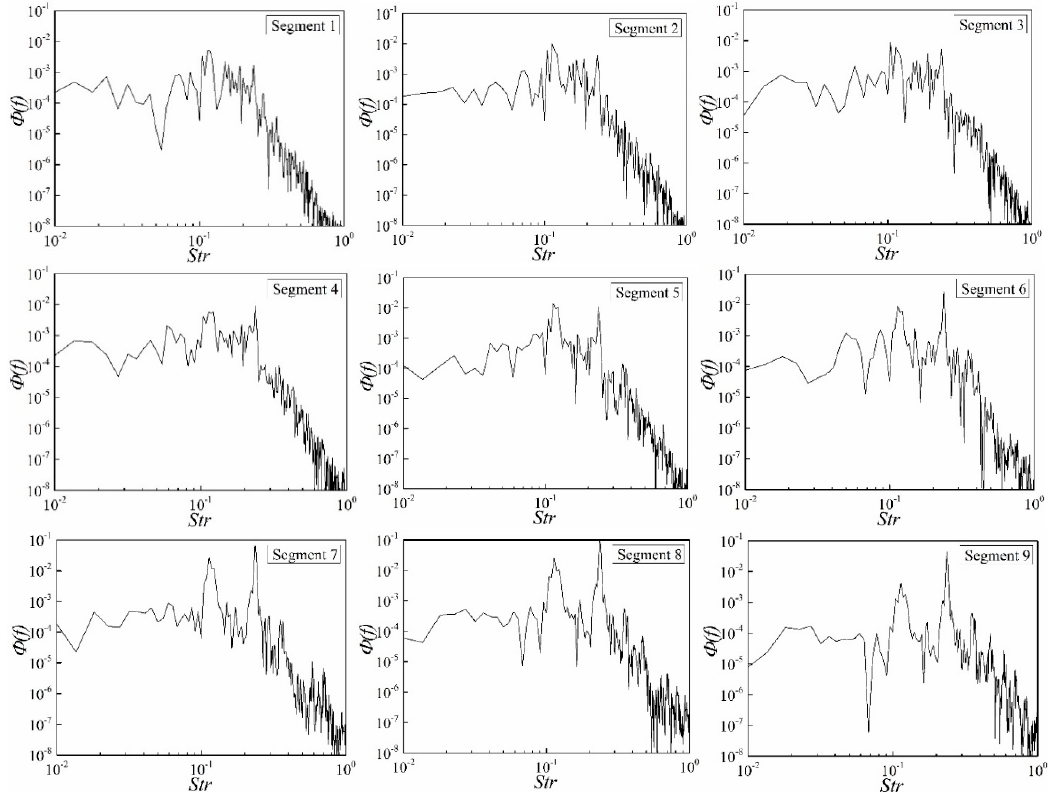
Figure 16. Power spectra of segmental lift coefficient at yaw angle of 45 ° .